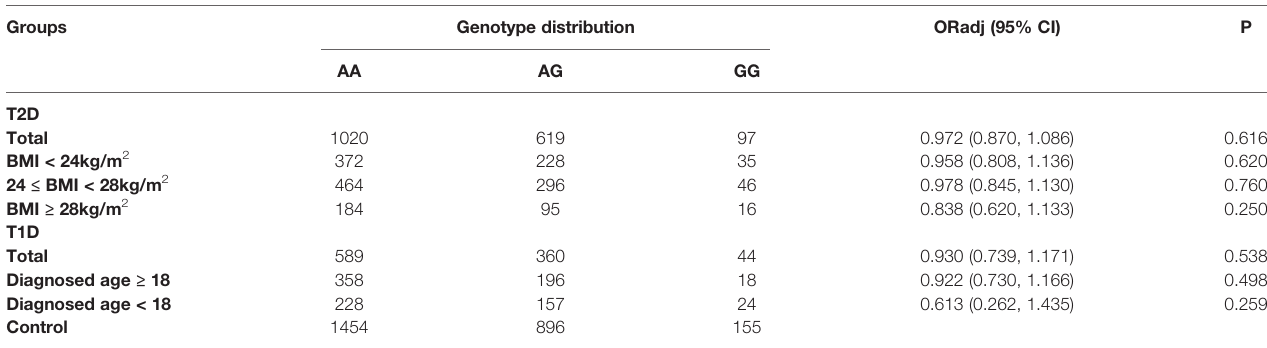
TABLE 2 | The association between the JAZF1 rs864745 A>G variant and T1D, T2D risk. Groups Genotype distribution